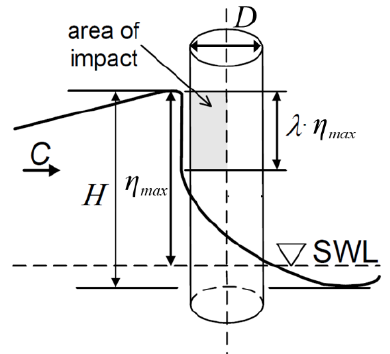
Figure 2. Definition sketch for an offshore breaking wave impact (Goda et al. (1966) [20]). Equation (3) estimates the maximum impulsive force acting on a cylinder according to Goda’s method. The curling factor depends on the breaker type as it represents the portion of the wave crest (η max ) over which the impact force acts on the cylinder. In the case of plunging breakers, which is expected to be the most critical condition for load intensity, Goda et al. (1966) [20] estimated a value of λ = 0.4 for vertical piles. Wiegel (1982) [24] subsequently recommended a value of λ = 0.5 for similar breaker types, which will lead to an over-estimation of the wave loads if Goda’s method correctly calculates those values. The peak impact force occurs when the breaker front first makes contact with the vertical cylinder, at time t = 0 , and then the impact force linearly decays as the breaker front propagates further.